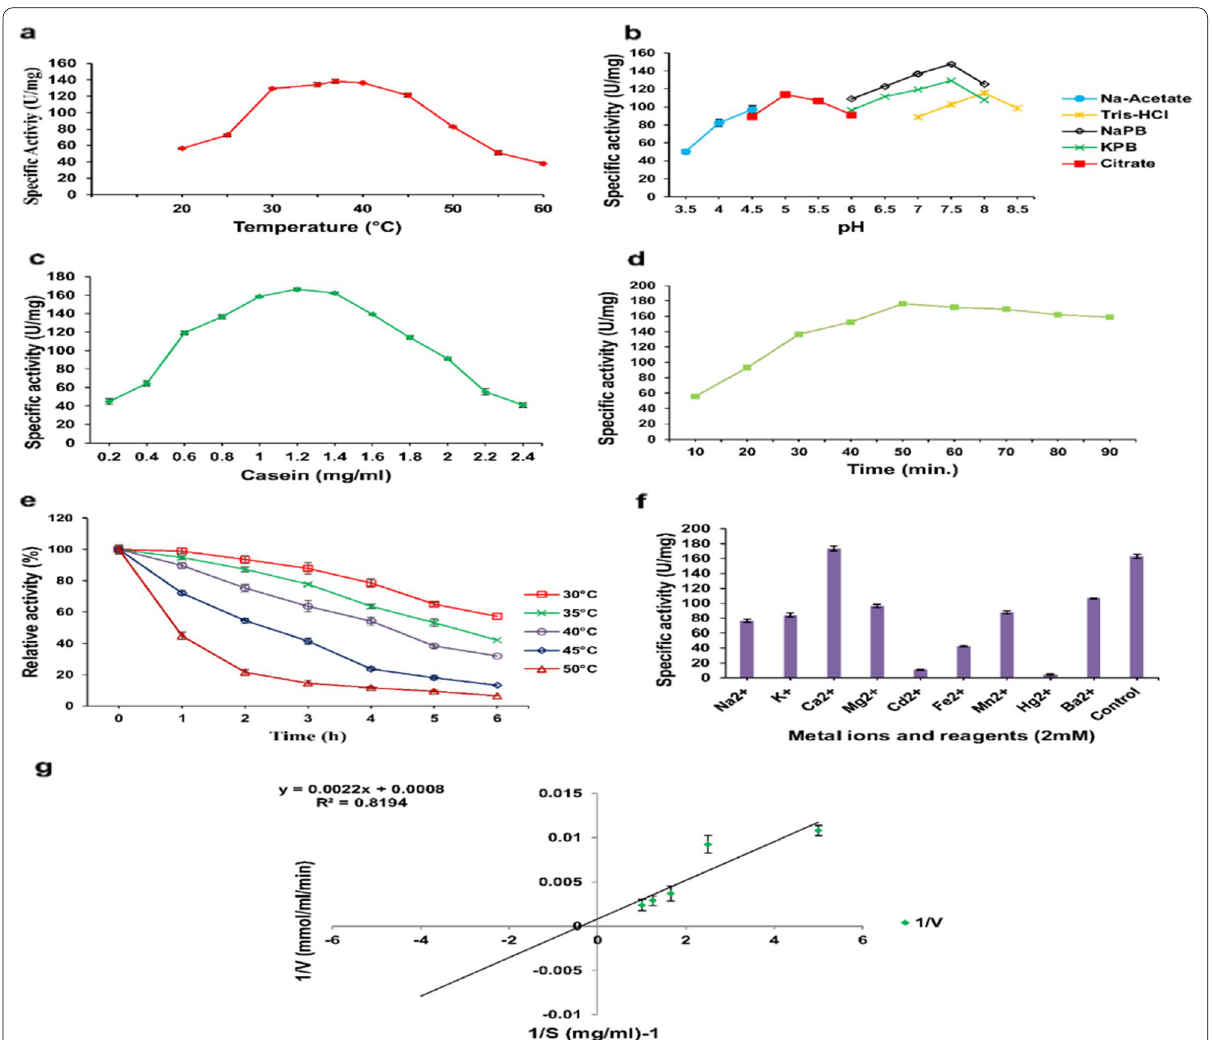
Fig. 2 a Effect of temperature on purified actinidin activity. b Effect of pH (3.5–8.5) on actinidin activity. c Effect of the substrate (casein) on the actinidin activity. d Effect of incubation time on the actinidin activity. e Effect of temperature on actinidin stability. f Influence of metal ions (2 mM) on actinidin activity. g Lineweaver–Burk plot of purified actinidin using casein as a substrate